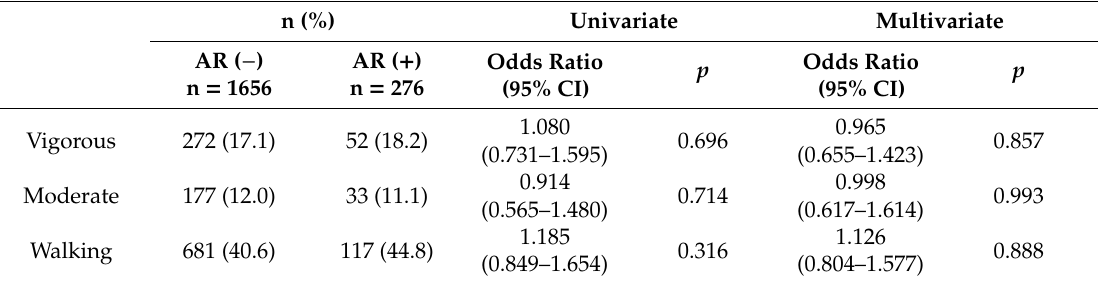
Table 2. Odds ratios for the association between physical activity and prevalence of allergic rhinitis in the total study population. n (%) Univariate